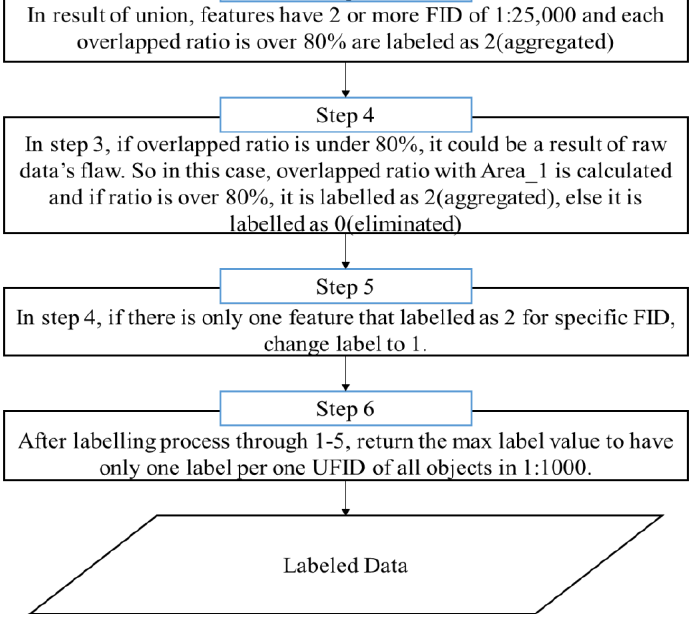
Figure 5. Building classification